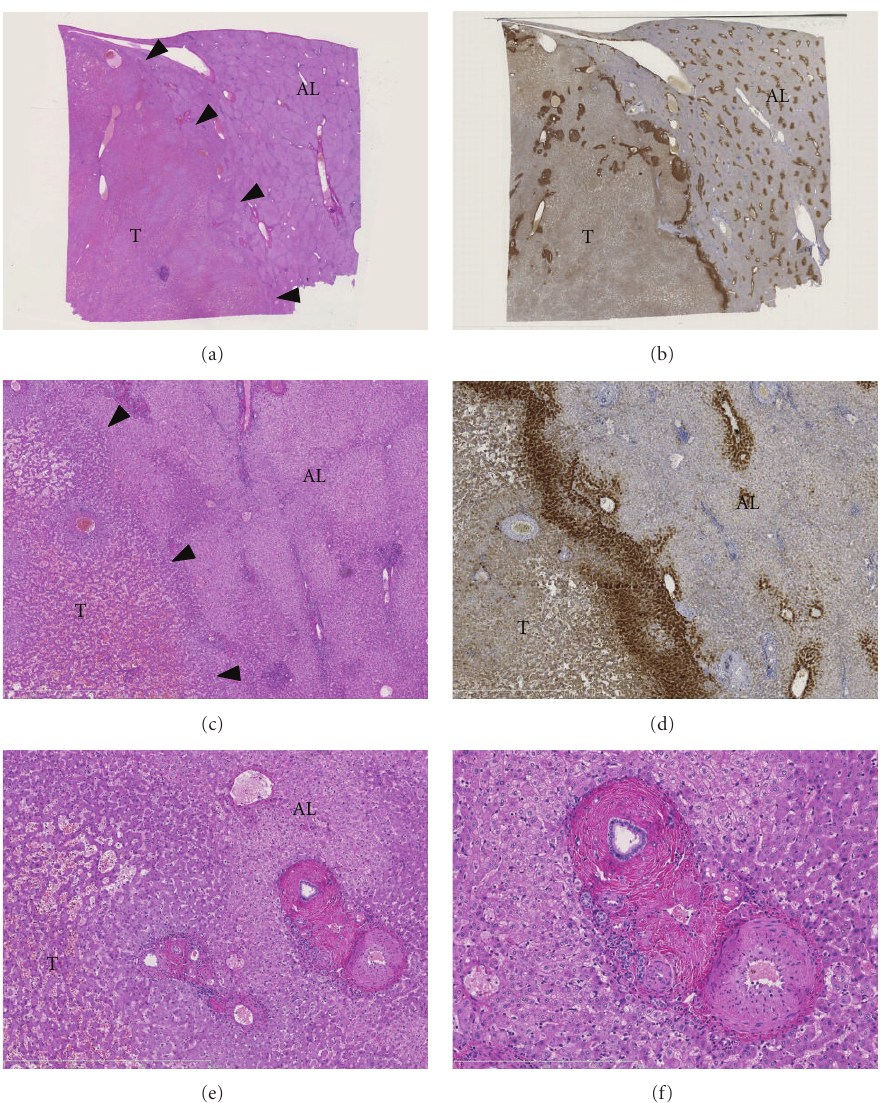
Figure 1: The transitional area of IHCA and adjacent liver. (a, c) HE stained whole slide (a) and detail (c) of a transitional area of an IHCA (T) and the nontumorous adjacent liver (AL). Arrowheads indicate the noncapsulated border of the tumor. (b, d) Glutamine synthetase expression of (a, c) highlights the di ff erence in architecture of IHCA and adjacent liver (AL). In the AL part, glutamine synthetase expression in perivenular areas accentuates the preserved lobular architecture. (e, f) Portal tracts containing thick-walled arteries at the border of tumor (T) and adjacent liver